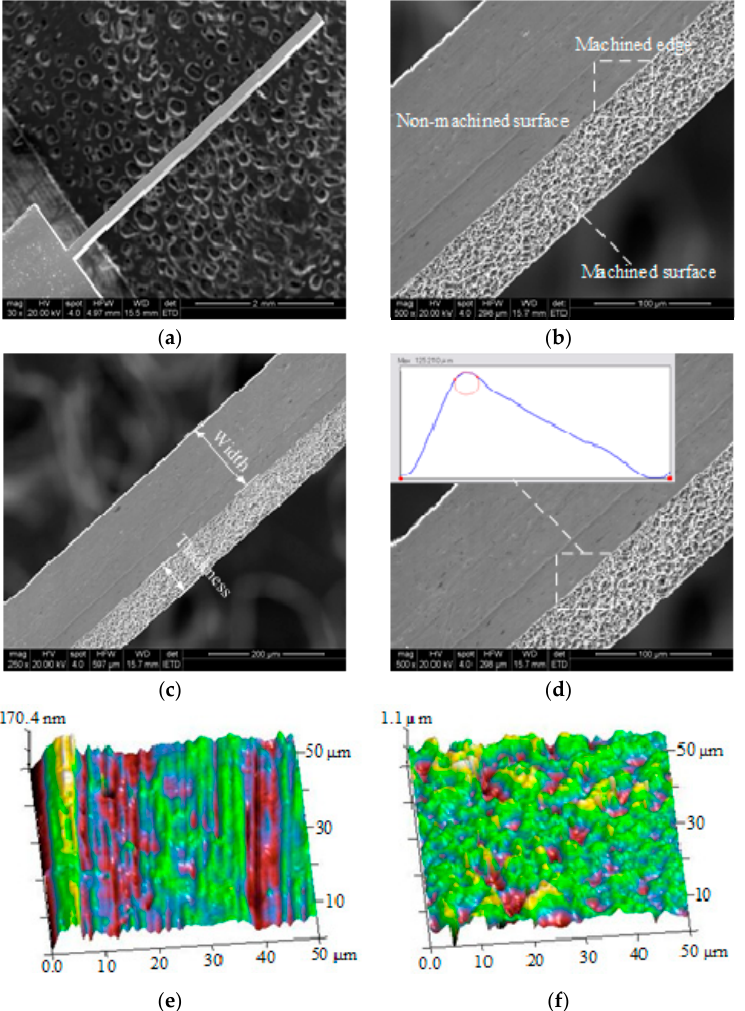
Figure 6. ( a ) SEM example of integral topography, ( b ) SEM image of local topography, ( c ) SEM example of the thickness and width, ( d ) SEM measurement example of the edge radius, ( e ) AFM example of the non-machined surface roughness, ( f ) AFM example of the machined surface roughness. Table 6. Measurement results of machining indicators of the pure aluminum rectangular mandrel.